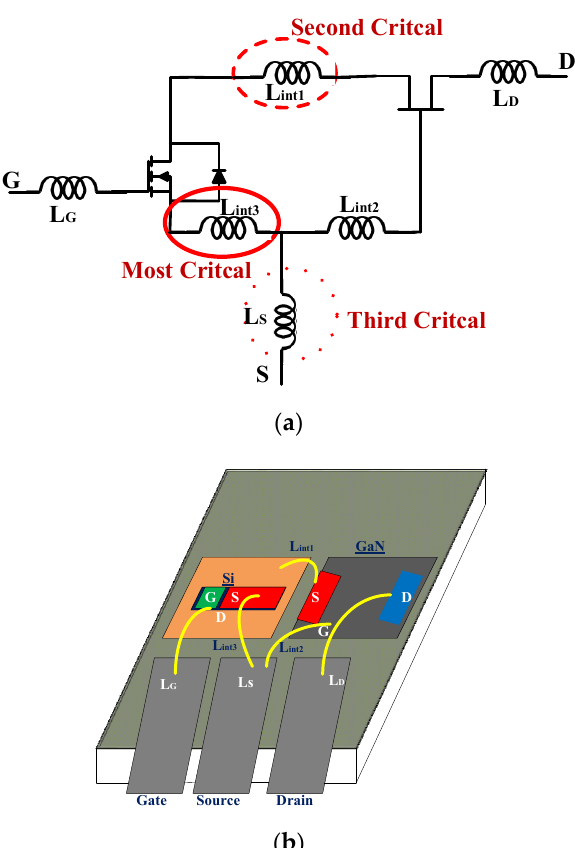
Figure 5. Cascode GaN HEMT: ( a ) package parasitic inductance schematic; and ( b ) TO-220 package simplified bonding diagram (adapted from [30]).